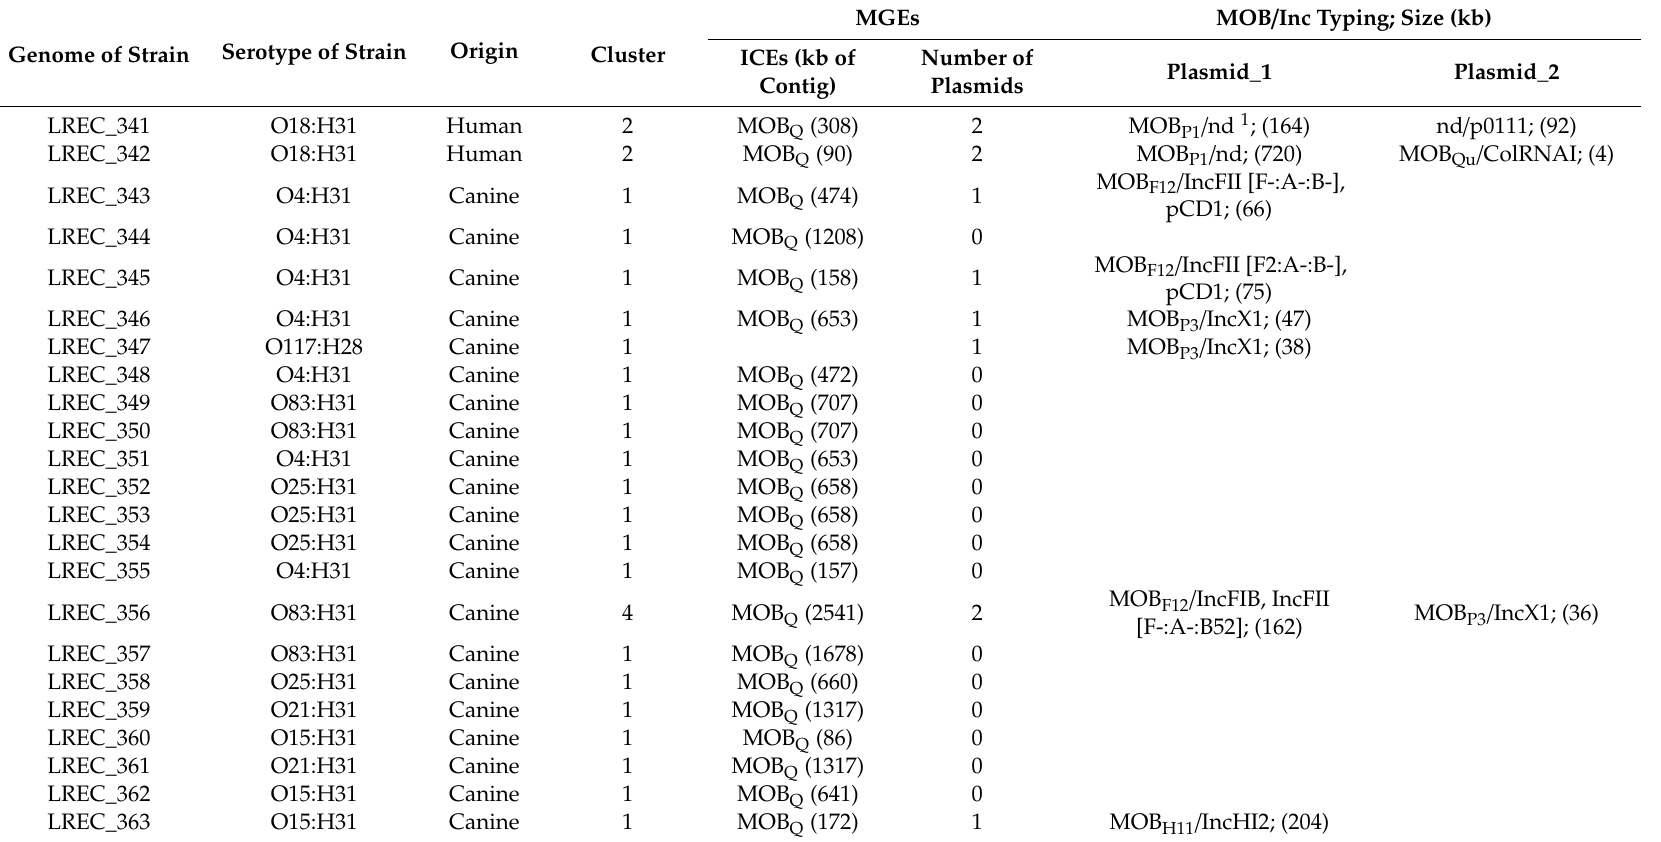
Table 10. Description of mobile genetic elements (MGE)s found in the 23 ST372 strain genomes sequenced in this study.